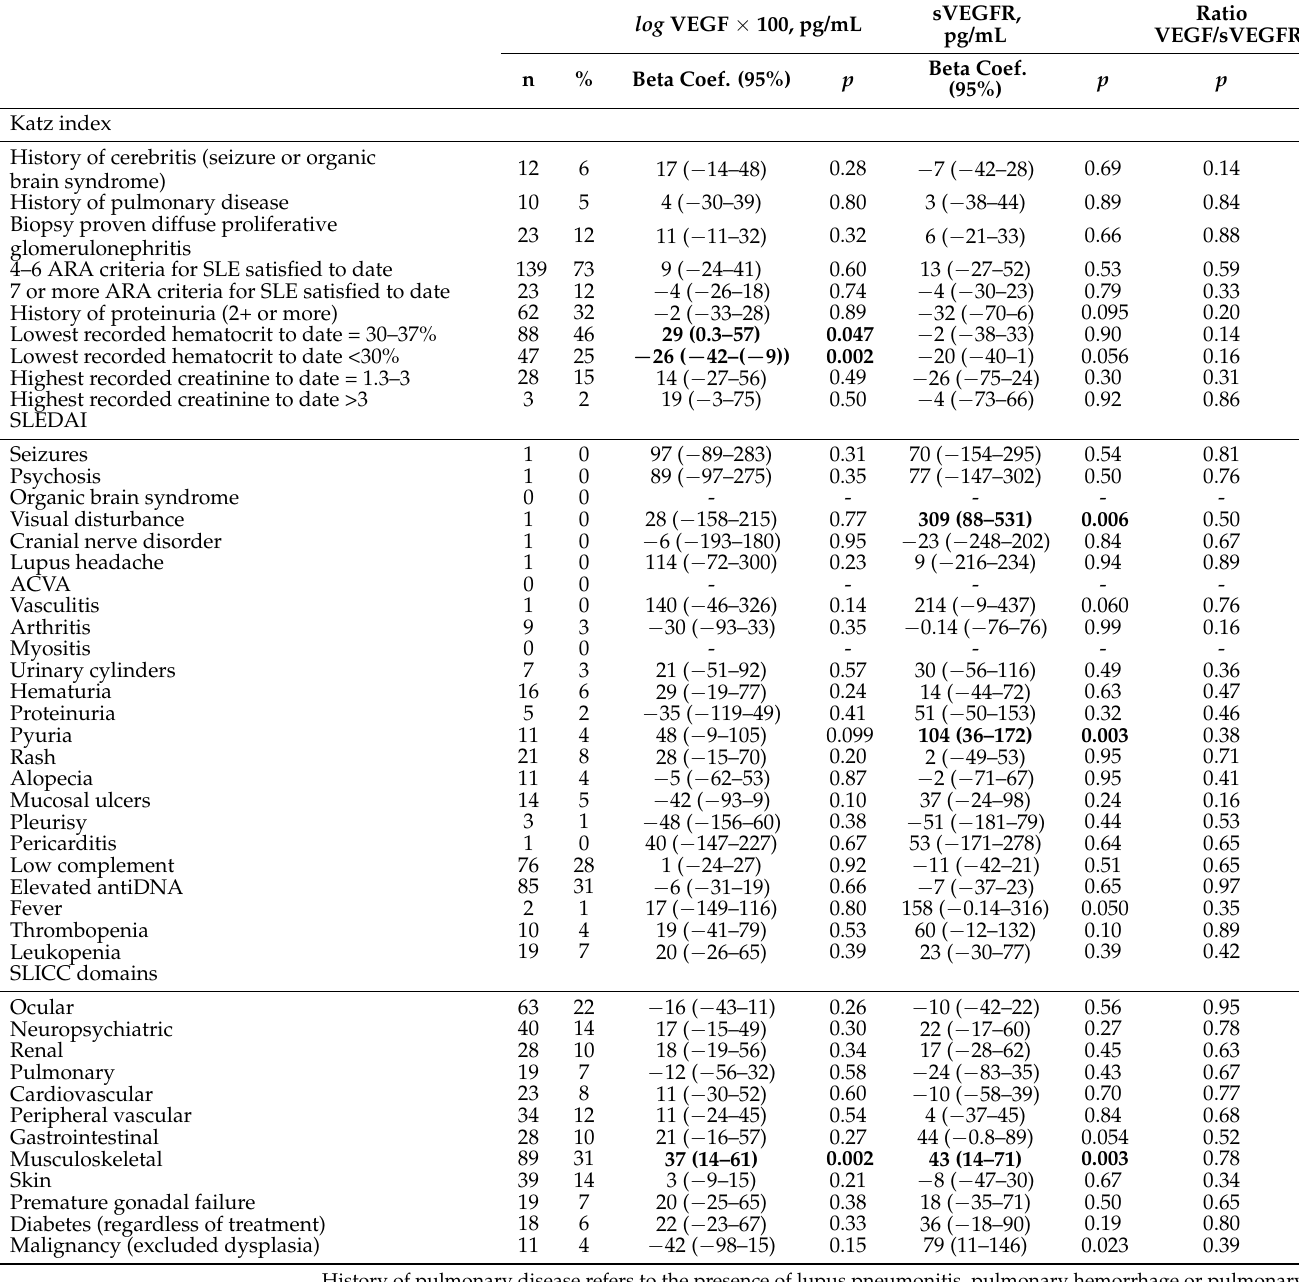
Table 3. Individual disease score items related to VEGF and sVEGFR serum levels.